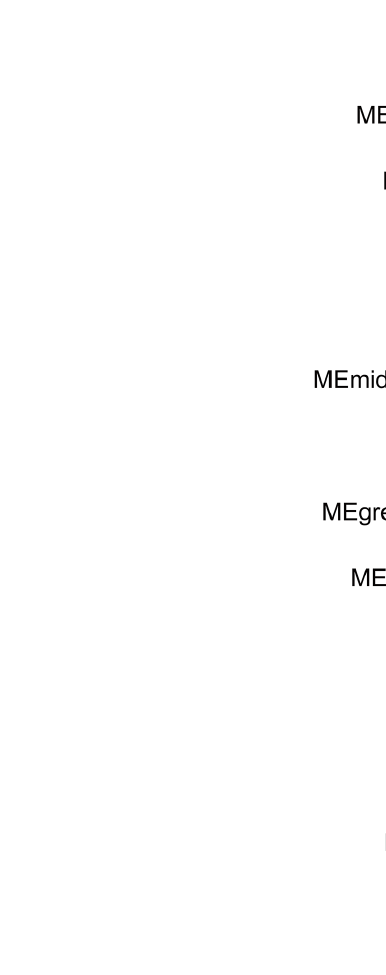
FIGURE 3 | Heatmap of the correlation between MEs and clinical traits. The background colors of the cells represent the strength of correlations, from red to green. The numbers in the cells represent the correlation coef fi cient, and the numbers in parentheses represent p-values. ME, module